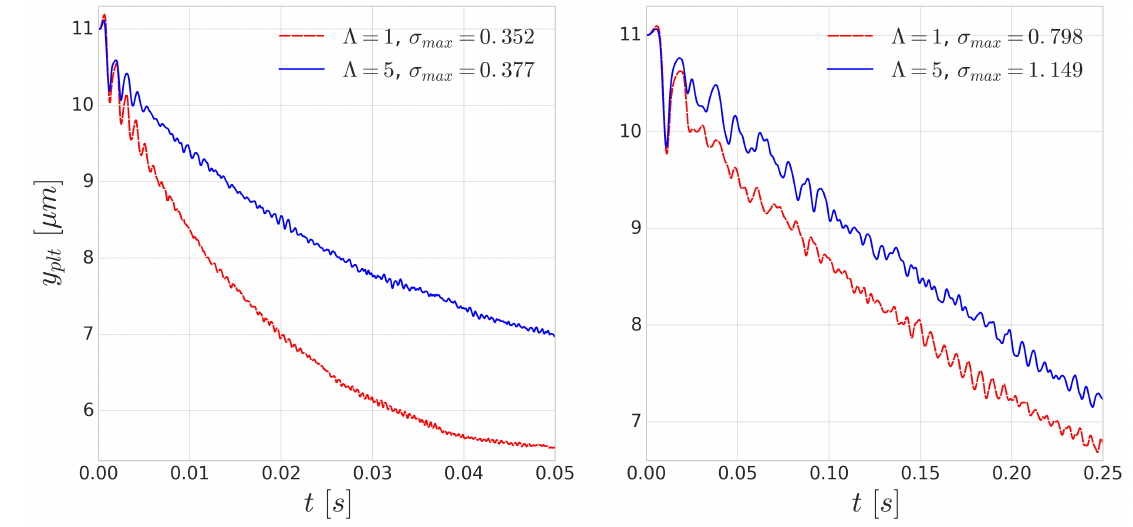
Figure 8. Average y -position of the platelet cell centre for different shear rates after repeated collisions with a red blood cell: ( Left ) ˙ γ = 4000 s − 1 ; and ( Right ) ˙ γ = 400 s − 1